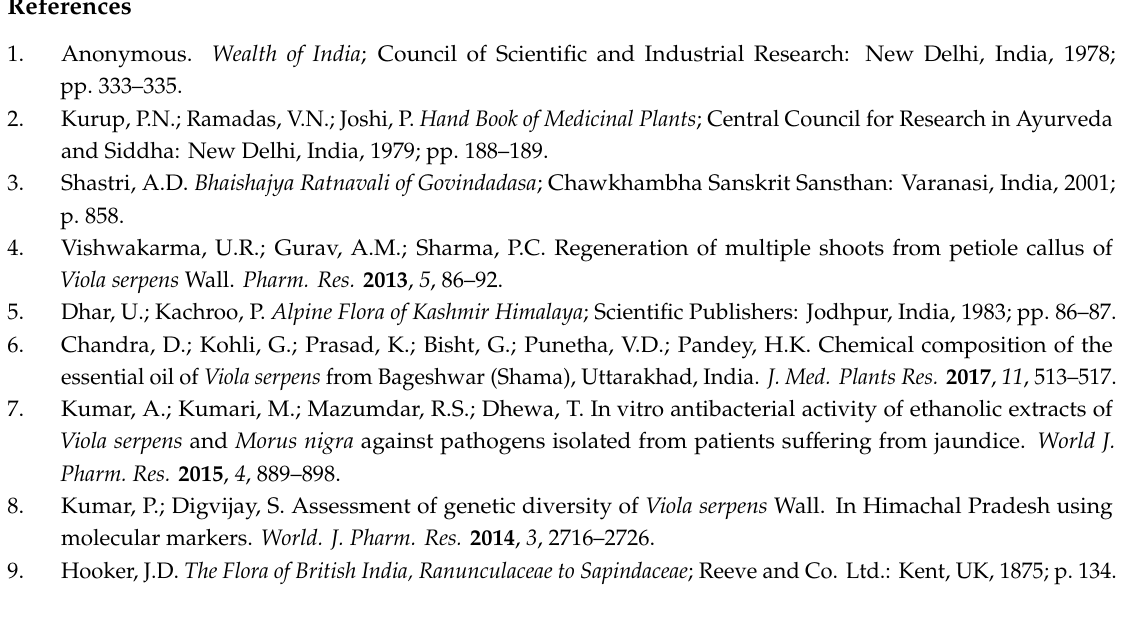
Table S1: E ff ect of di ff erent plant growth regulators (PGRs) on leaf explants of Viola serpens for callus formation, Table S2: RAPD primers along with sequences, Table S3: Number of amplification products generated by 20 arbitrary primers in di ff erent accessions of Viola serpens , and Table S4: Commercial crude drug samples collected from the market place of New Delhi,